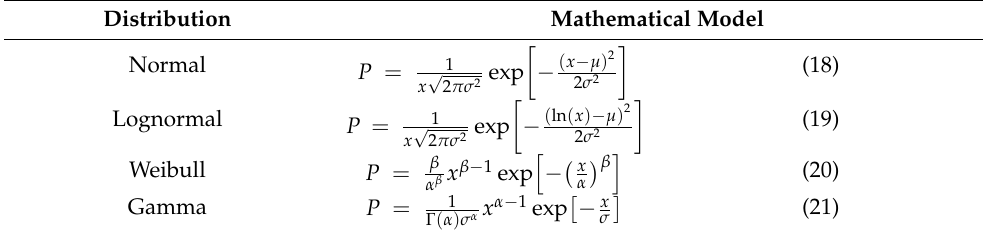
Table 1. Tested probability